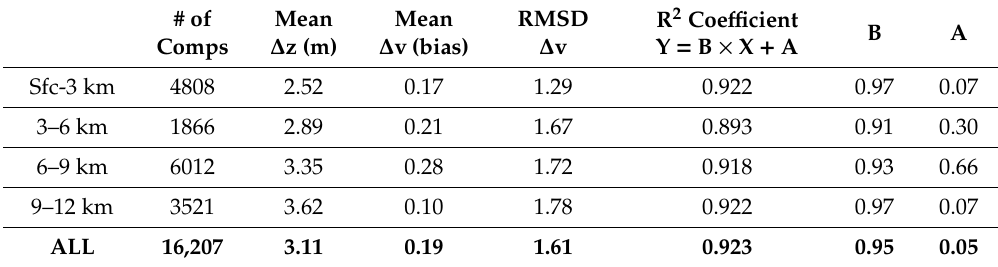
Figure 10. Scatterplot of DAWN-dropsonde comparison of wind speed ( a ) and wind direction ( b ) during CPEX. Table 7. DAWN-dropsonde comparison statistics by height for v component of the horizontal wind.